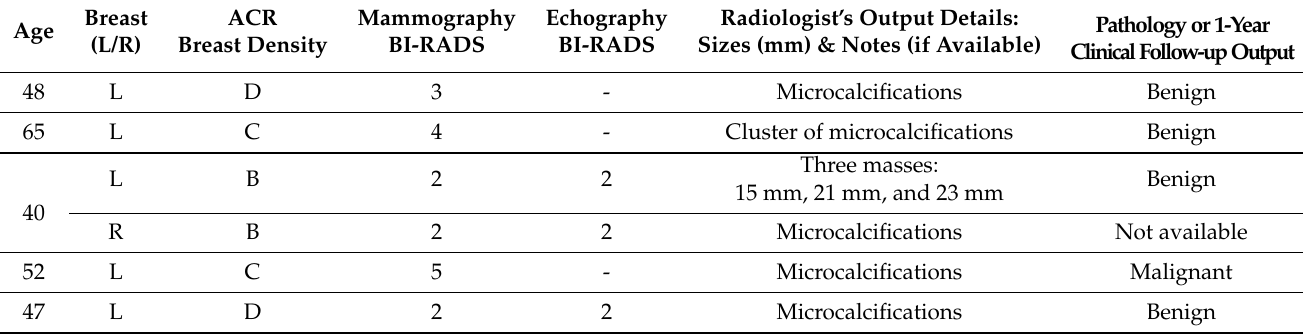
Table 2. Details and related radiologist’s review for the breasts with radiological findings